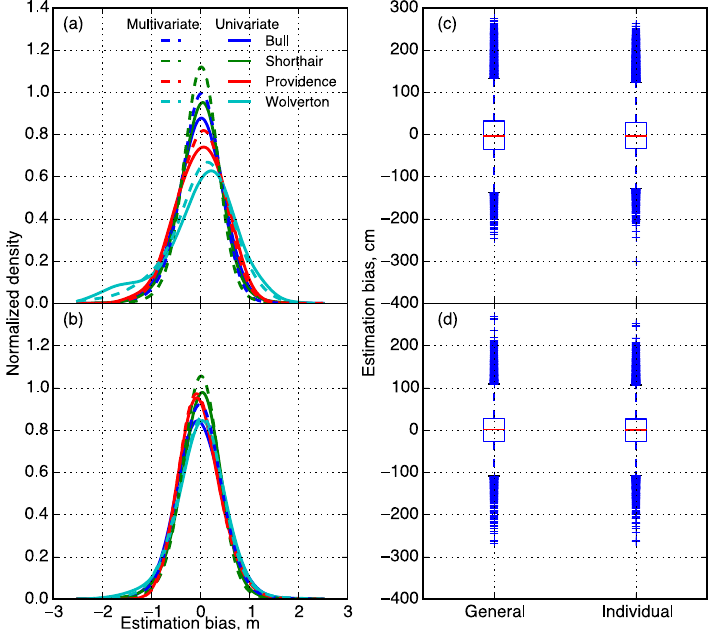
Figure 10. Normalized density of estimation bias for (a) open and (b) under-canopy areas. Estimation bias boxplots of using one general linear-regression model with all sites’ data combined and four linear-regression models of each individual site for (c) and open (d) under- canopy areas.